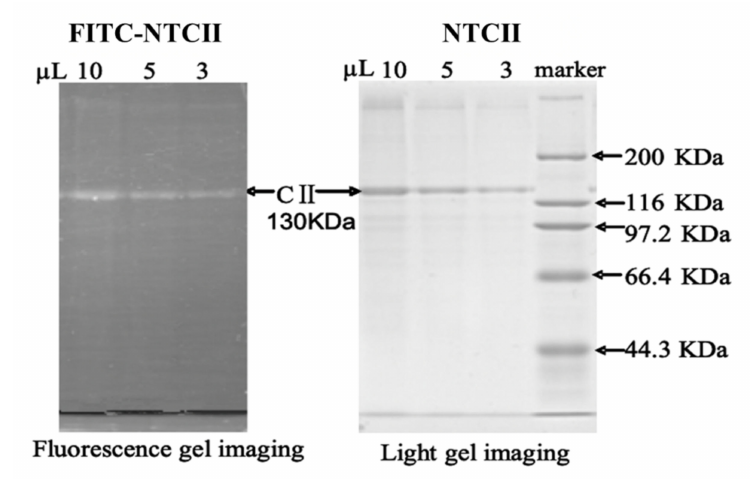
Figure 2. The result of fluorescent labeling by SDS-PAGE.